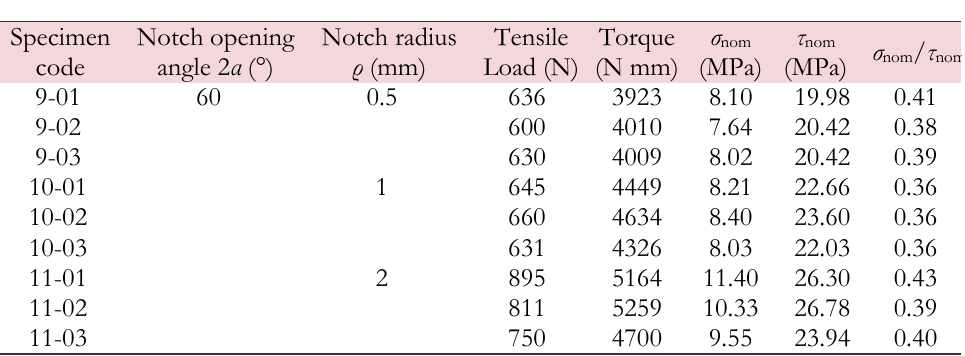
Table 2: Experimental results in the case of σ nom / τ nom = 0.4; notch depth p = 5 mm.